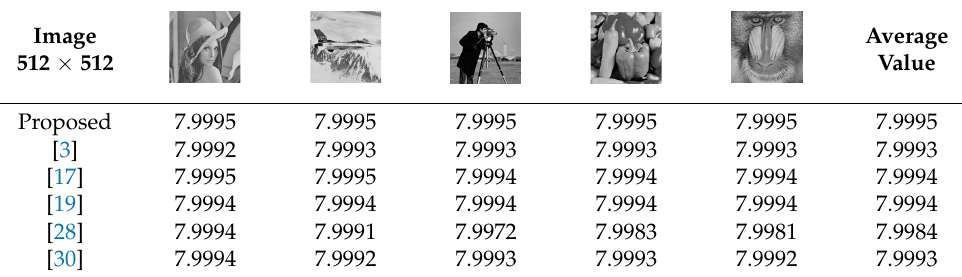
Table 6. Comparison of information entropy.